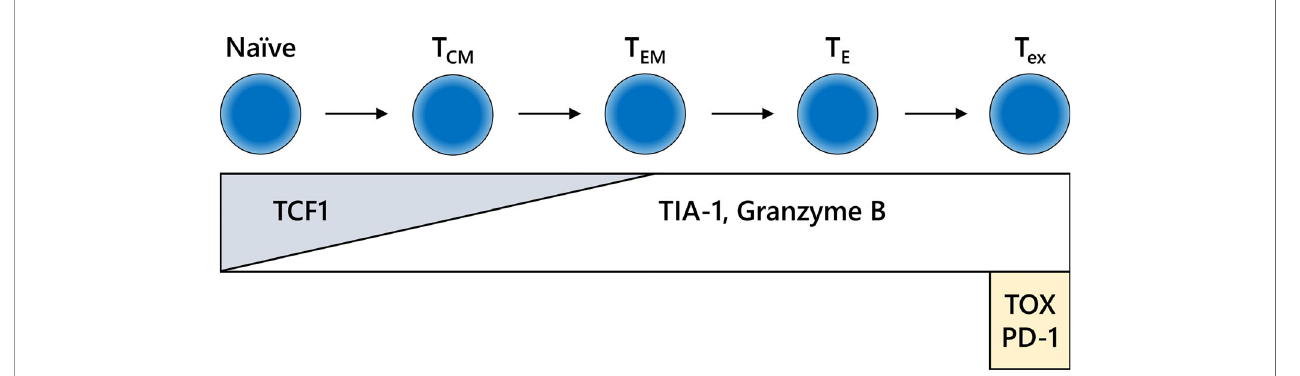
FIGURE 4 | Differentiation fate and immunohistochemistry (IHC) markers for CD8-positive T cells. The behavior of CD8-positive T cells is dependent on the differentiation stage, which is not clearly de fi ned. The schema shown here is extremely simpli fi ed. IHC for formalin- fi xed paraf fi n-embedded specimens may reveal the functional relevance of CD8-positive T cells in each stage of differentiation. T CM , central memory T cell; T E , effector T cell; T EM , effector memory T cell; T ex , exhausted